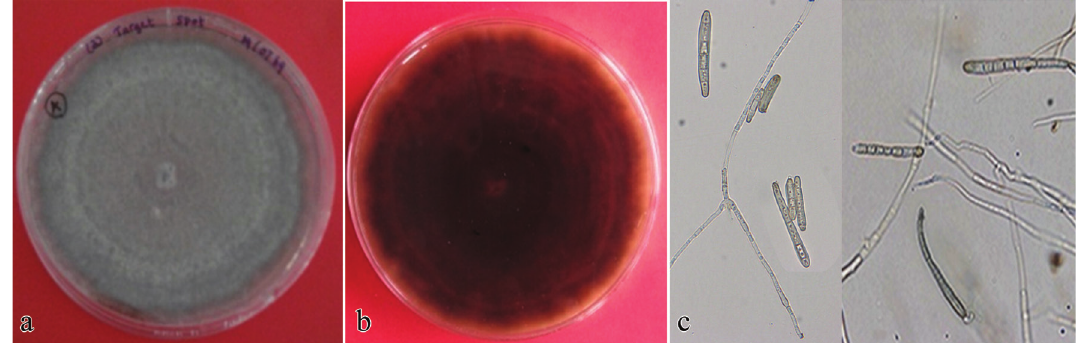
Figure 2: a) Upper and, b) lower surface view of C. cassiicola isolate TS1 grown on PDA after 10 days, and c) conidia (x 400).